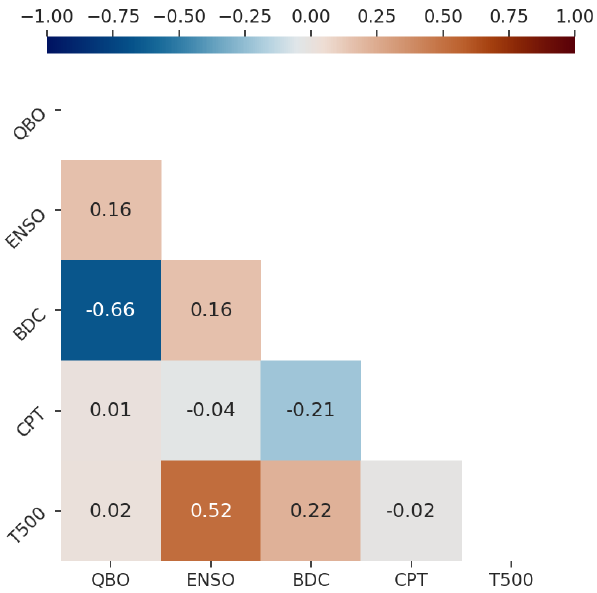
Figure 2. A correlation heat map for the predictors used in the anal- ysis. The time span is from 1994 to